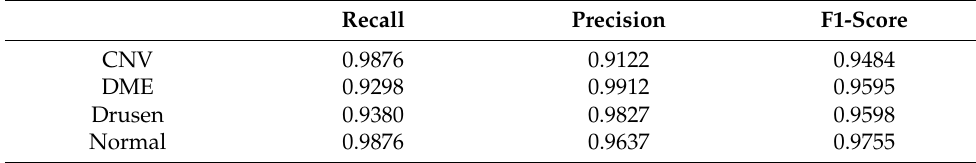
Table 4. CNN model with 3 hidden layers.